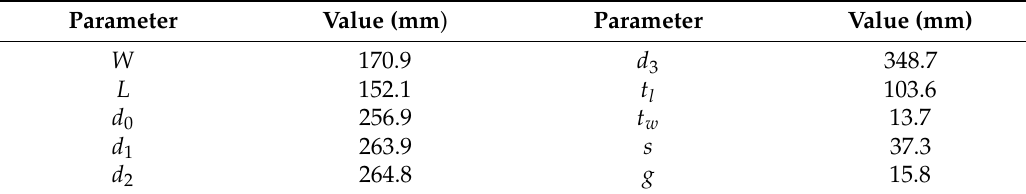
Table 2. Optimized Structure Dimensions.